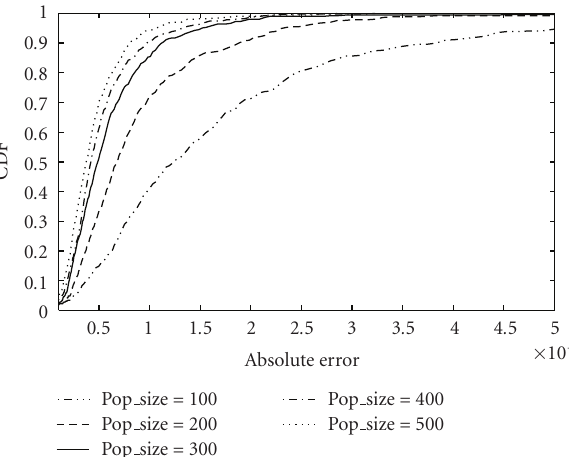
Figure 9: CDF (Cumulative Distribution Function) of the absolute percentage error in thresholds optimization with various popula- tion sizes.